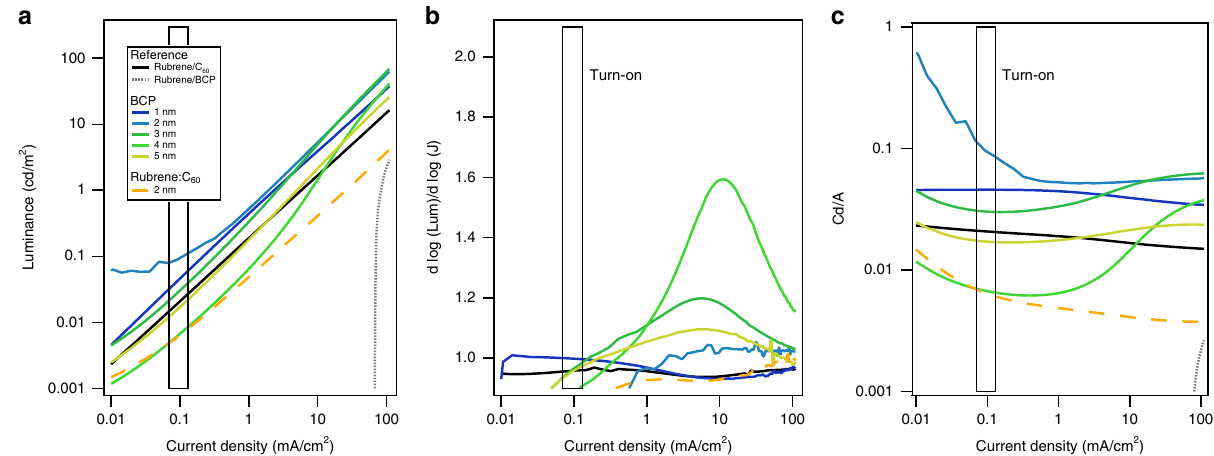
Fig. 8 Detailed luminescence characteristics. a L ( J )-characteristics of rubrene/BCP and rubrene/C 60 OLEDs as a function of interlayer thickness. b ∂ log( L )/ ∂ log( J ) and ( c ) current ef fi ciency for the same devices as shown in a . The beginning of the “ turn-on ” area is indicated. Note that at high-current densities (>100 mA/cm 2 ), the device is series-resistance